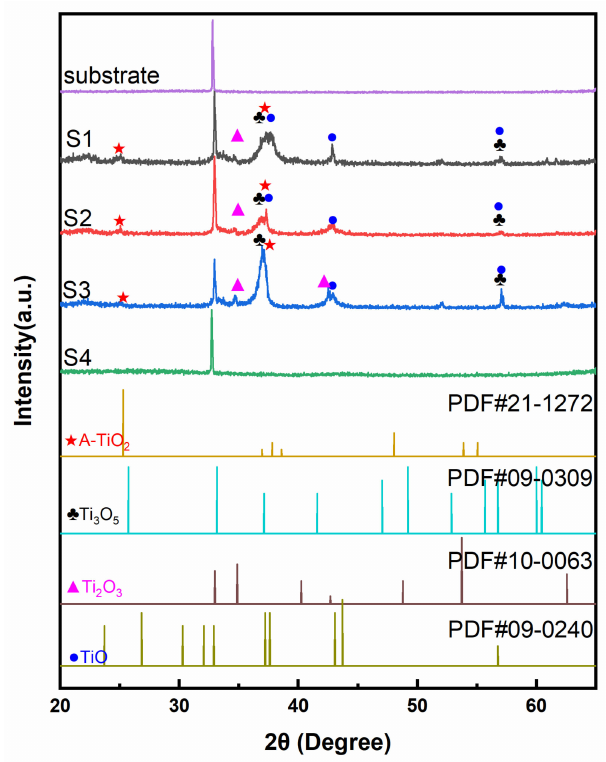
Figure 1. The XRD patterns of Samples S1, S2, S3, and S4, substrate, and pure anatase TiO 2